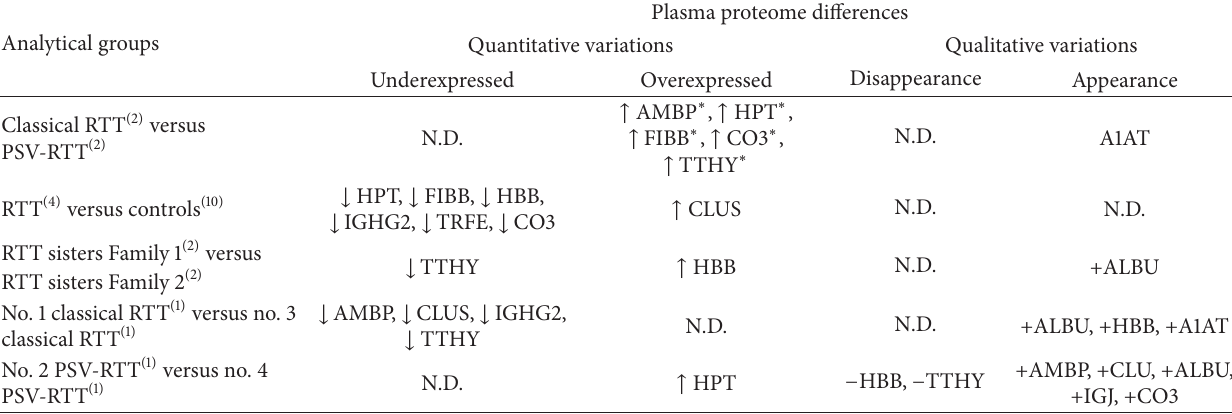
Table 3: Protein variations as derived from the examined RTT sister pairs and healthy controls comparative analyses. Plasma proteome differences Analytical groups Quantitative variations Qualitative variations Underexpressed Overexpressed Disappearance Appearance ↑ AMBP ∗ , ↑ HPT ∗ , Classical RTT (2) versus ↑ FIBB ∗ , ↑ CO3 ∗ , N.D. A1AT N.D. PSV-RTT (2) ↑ TTHY ∗ N.D. N.D. IGHG2, ↓ TRFE, ↓ CO3 N.D. +ALBU N.D. N.D. +ALBU, +HBB, +A1AT TTHY +AMBP, +CLU, +ALBU, N.D. +IGJ, PSV-RTT (1)